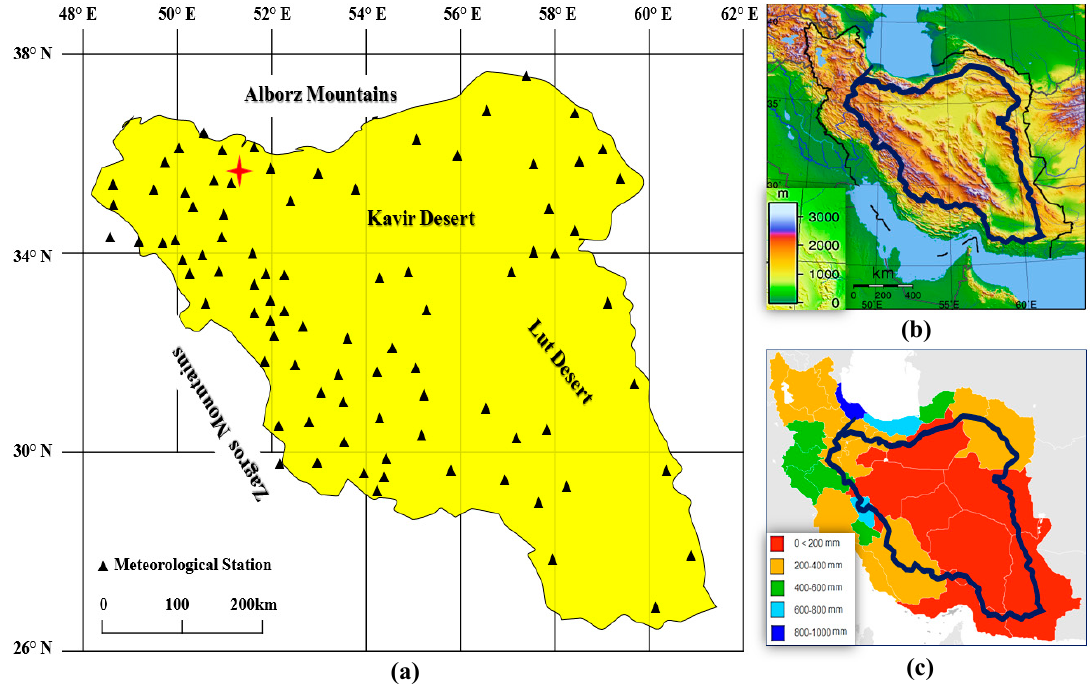
Figure 1. The area under study. ( a ) The catchment area and meteorological station located in and around, ( b ) Topography, ( c ) Average annual precipitation.